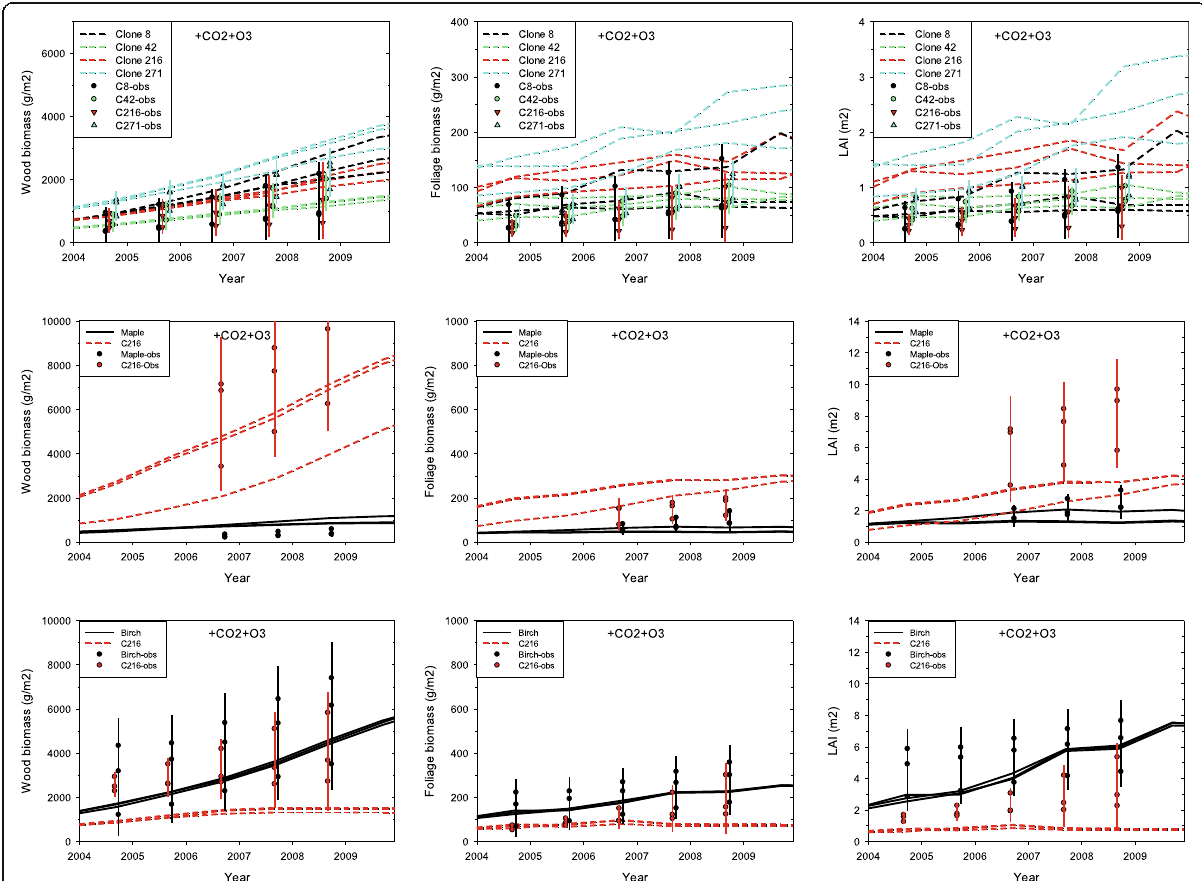
Fig. 4 Comparison of modeled values (dashed lines show each replicate) with empirical observations (symbols) of mid-summer values under elevated CO2 and O3 (+CO2+O3) conditions. Symbols and 95% confidence intervals (vertical solid lines) are offset to enhance visual clarity ( N =